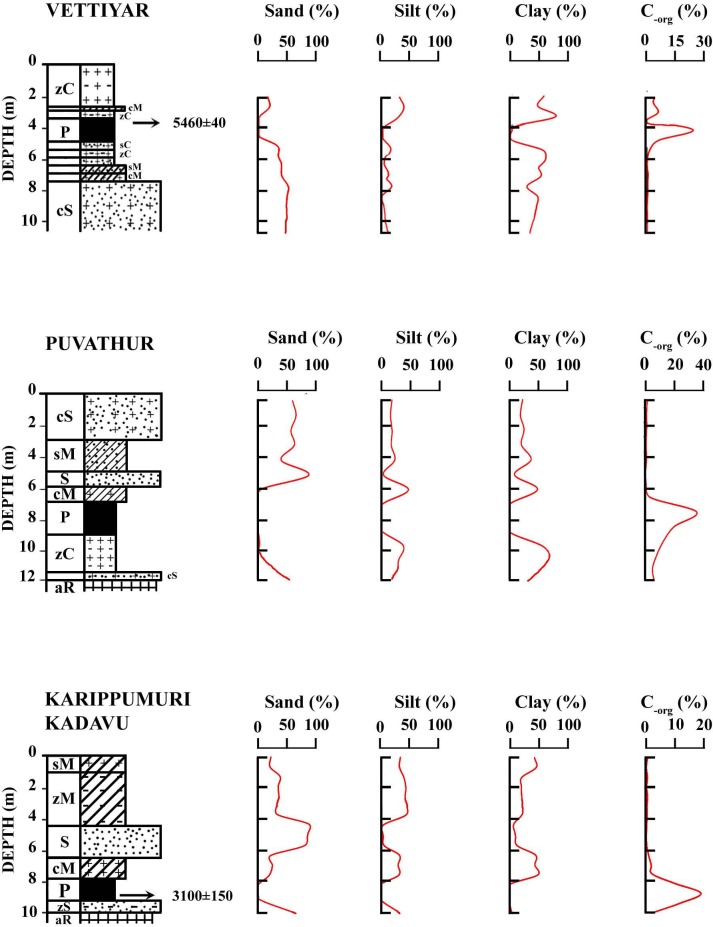
Downcore variation of sand, silt and clay contents of Vettiyar, Puvathur and Karippumuri kadavu borehole cores along with organic carbon (Corg) content.